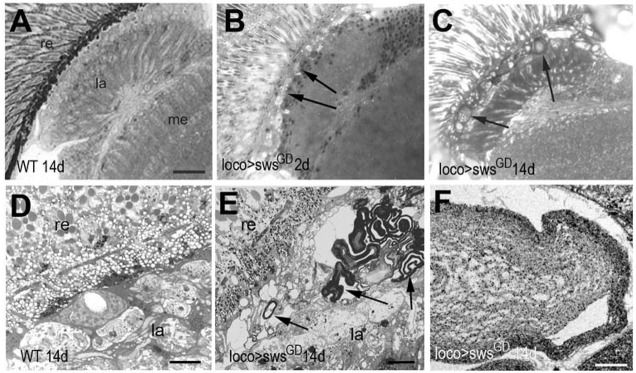
The glial knockdown of SWS induces the formation of membranous glial bodies. (A) A 1-µm plastic section reveals an intact lamina cortex in a 14-day-old (14 d) wild-type (WT) fly. (B) In 2-day-old loco-GAL4;swsGD animals, small membranous structures are detectable in the distal lamina cortex (arrows); these structures become larger when these flies are 14 days old (C, arrows). (D) Electron microscopic image showing the intact lamina cortex in a 14-day-old wild type. (E) A 14-day-old loco-GAL4;UAS-swsGD3277 fly shows a highly disrupted lamina cortex and the formation of electron-dense multilayered membranous structures (arrows). A magnification of one of these structures is shown in F. Scale bar in A: 15 µm, in D,E: 2 µm, in F: 100 nm. re, retina; la, lamina; me, medulla.